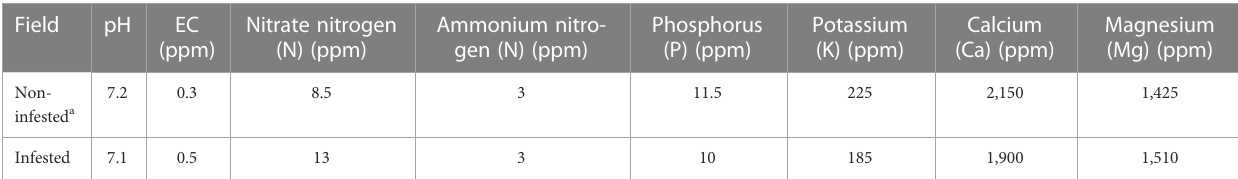
(Table 1). Pathogen treatments consisted of the Fol R3 isolate